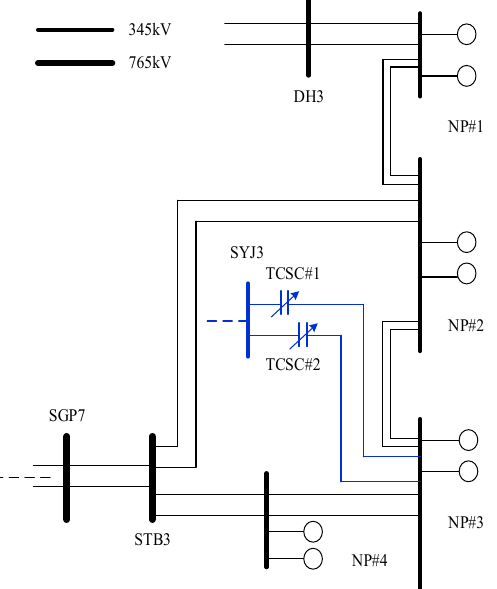
Figure 6. Simplified East Coast schematic for relocation review. Table 1. Line Impedance before and after relocation.